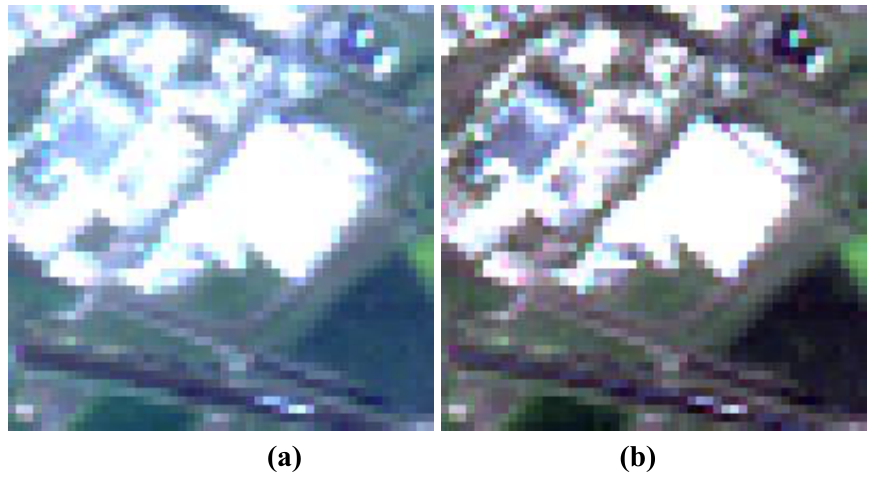
Figure 3 . ( a) original scene RBG=3,2,1; (b) after atmospheric correction with haze removal. Red coding in (c) to (f) represents the saturated pixels in bands 1, 2, 3, and bands 1+2+3,